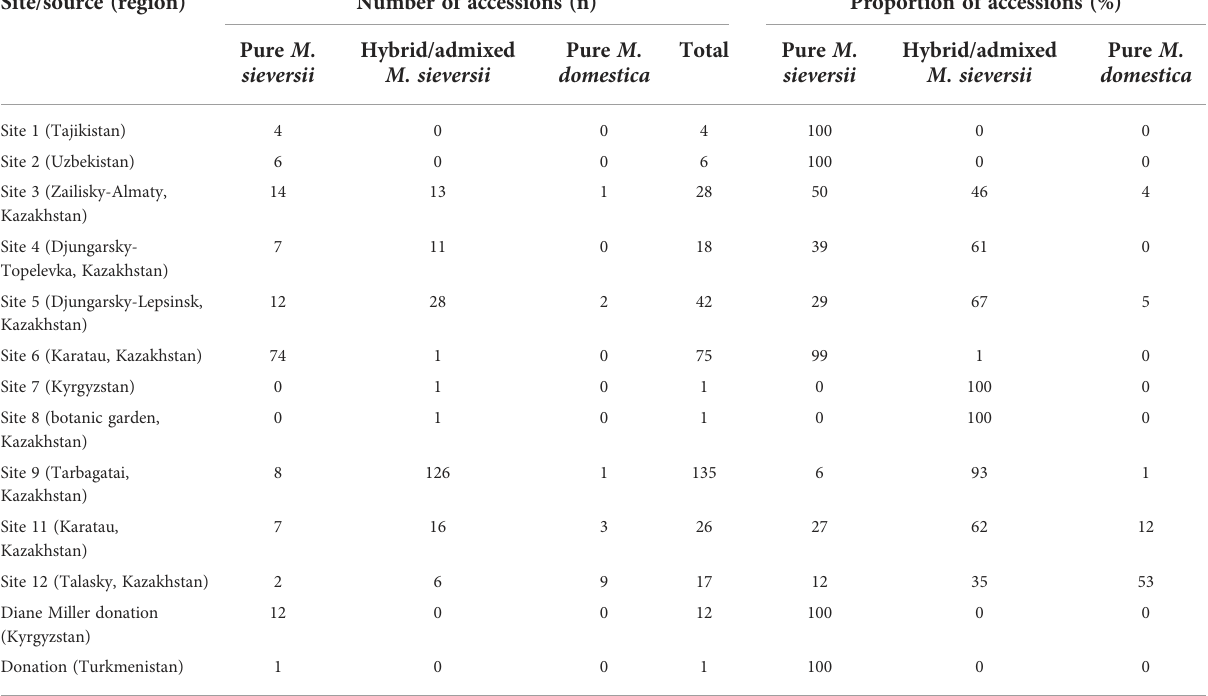
TABLE 1 Species compositions determined for NPGS Malus sieversii collection sites representing various regions in Central Asia. Site/source (region)